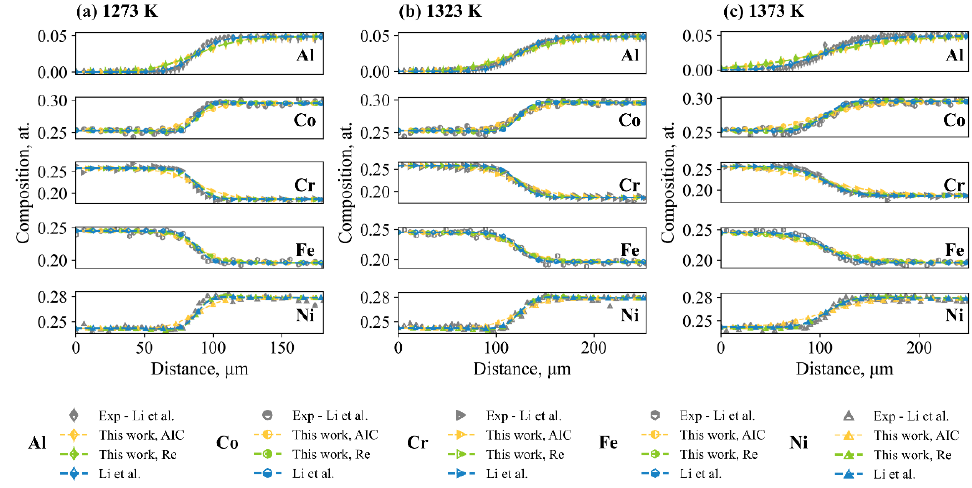
Figure 2. Comparison of the typical composition profiles among the experimental results (Li et al. [20]) and model-predicted results due to Li et al., optimization with parameter selection based on AICc and optimization with regularization based on L2 norm penalty: ( a ) 1273 K; ( b ) 1323 K; ( c ) 1373 K.